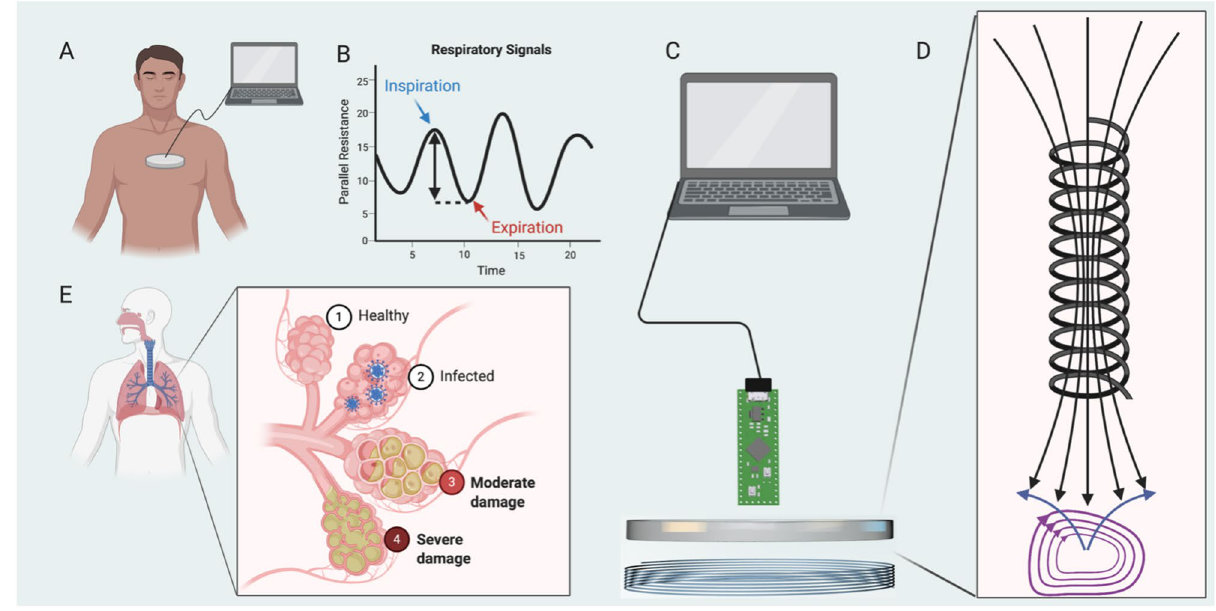
Figure 2. Experimental setup and sensor principles. ( A ) During static pulmonary testing, the sensor is placed on the mid-chest, with data recorded and stored on a local computer. ( B ) Fluctuations in parallel resistance during scanning result in a cyclical time-series waveform, with inspiration resulting in local maxima and expiration resulting in local minima. The difference between maxima and minima yield parallel resistance changes per breath. ( C ) The sensor is constructed as a solenoid with 6 turns on a plastic scaffold connected to a commercial inductance-to-digital converting chip which is powered via a USB connection. ( D ) The